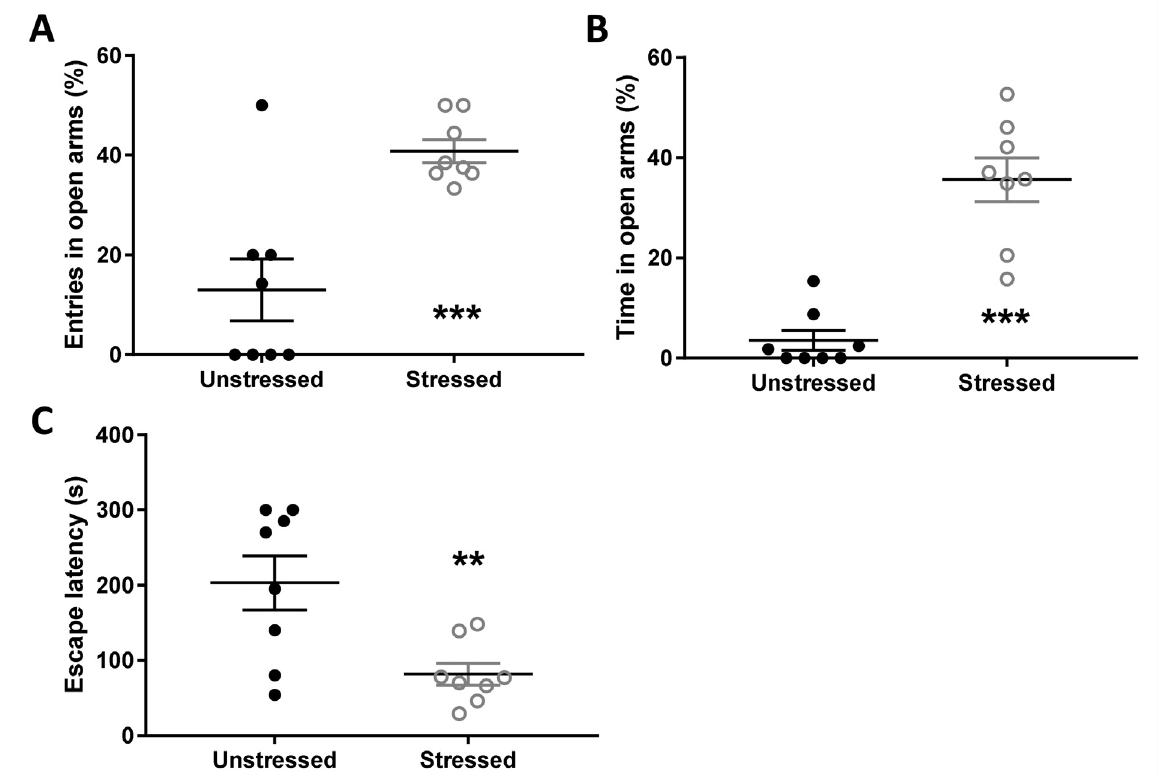
Figure 2. Early life maternal separation stress resulted in increased anxiolytic behavior in male rats. Ordinate depicts number of entries and into the open arm relative to total entries in open and enclosed arms of the elevated plus maze ( A and B , respectively) and latency to emerge from the home cage into a novel environment ( C ). Line graphs depict mean and standard error of the mean for unstressed (black) and stressed (gray) male rats. *, p < 0.05; **, p < 0.01; unpaired two-tailed Student’s t-test (n = 8 animals in each experimental group).